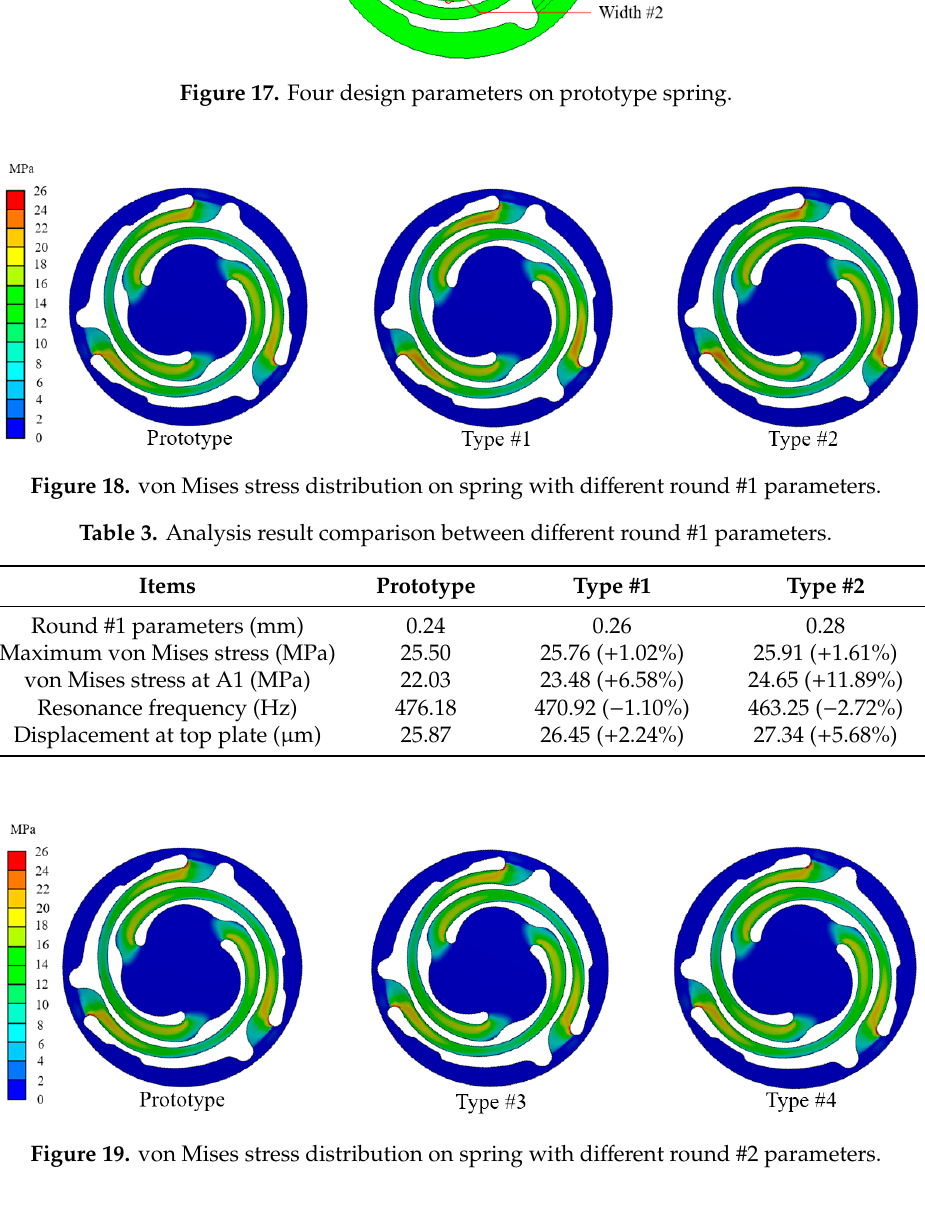
Figure 17. Four design parameters on prototype spring.